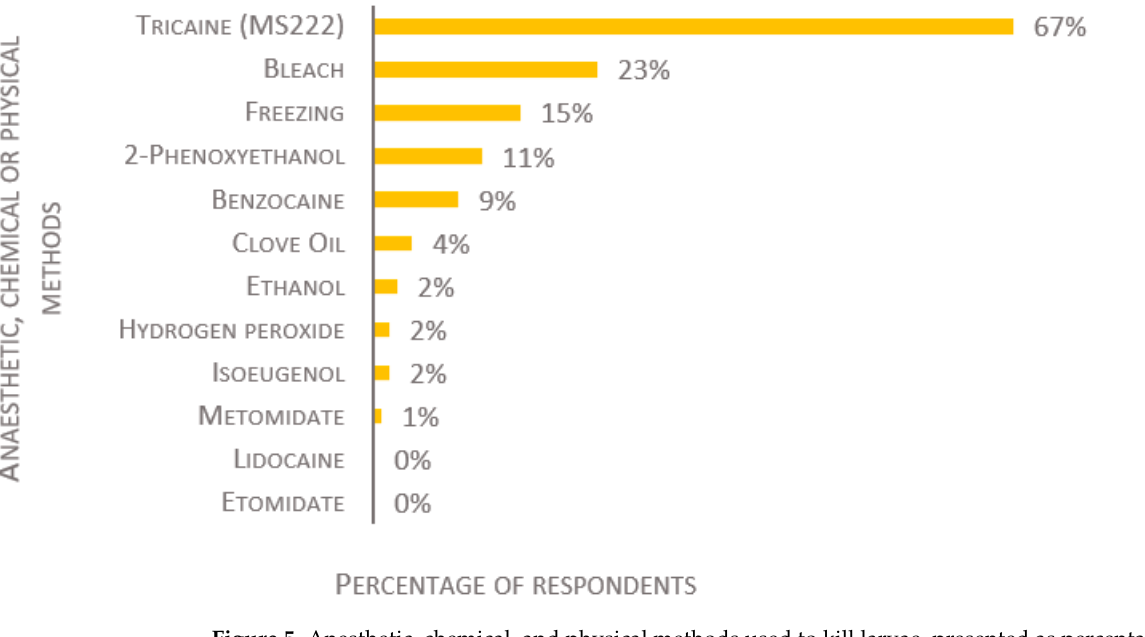
Figure 4. Compounds used to induce an overdose of anesthesia in adults and fry, presented as percentage of respondents ( n = 134 for adults and 129 for fry). Each respondent was allowed to select multiple answers.